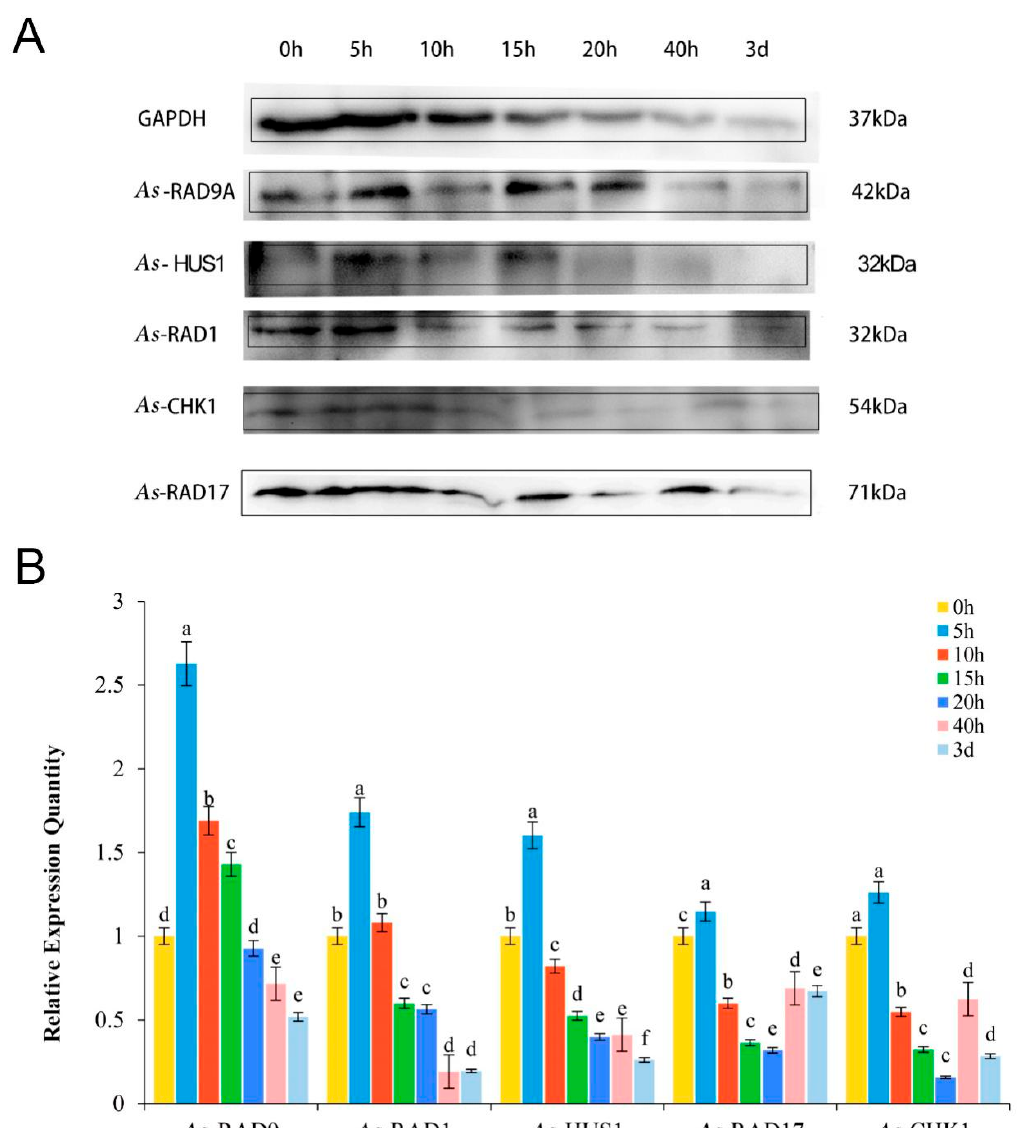
Figure 5. Western blot analyses of As –RAD9, As –RAD1, As –HUS1, As –RAD17, and As –CHK1 at di ff erent developmental stages (0 h–3 days) of A. sinica . ( A ) The intensities of the protein bands were normalized against those of GAPDH. ( B ) Values are expressed as arbitrary units of relative value. The x-axis indicates the di ff erent protein; the y-axis shows the relative expression level. Significant di ff erences at di ff erent development stages ( P < 0.05) were analyzed by one-way analysis of variance (ANOVA) and reported by lowercase letters (a – e).